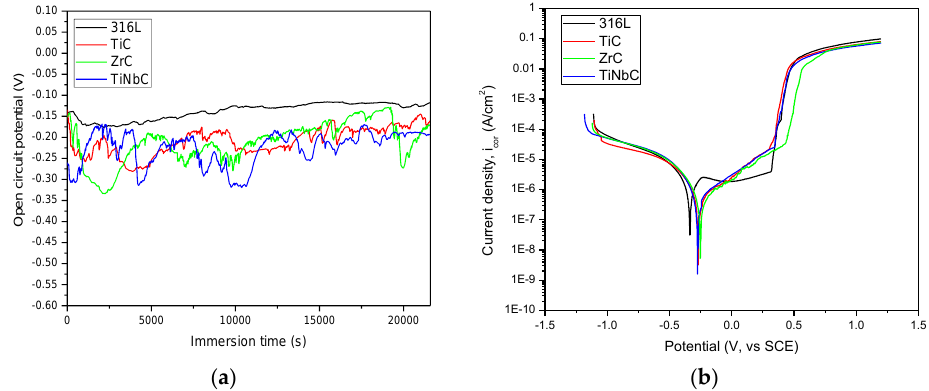
Figure 5. ( a ) Evolution of open circuit potential versus time in 0.9% NaCl at 37 ± 0.5 °C (immersion 1 h); ( b ) Potentiodynamic curves of the investigated surfaces in 0.9% NaCl at 37 ± 0.5 °C.